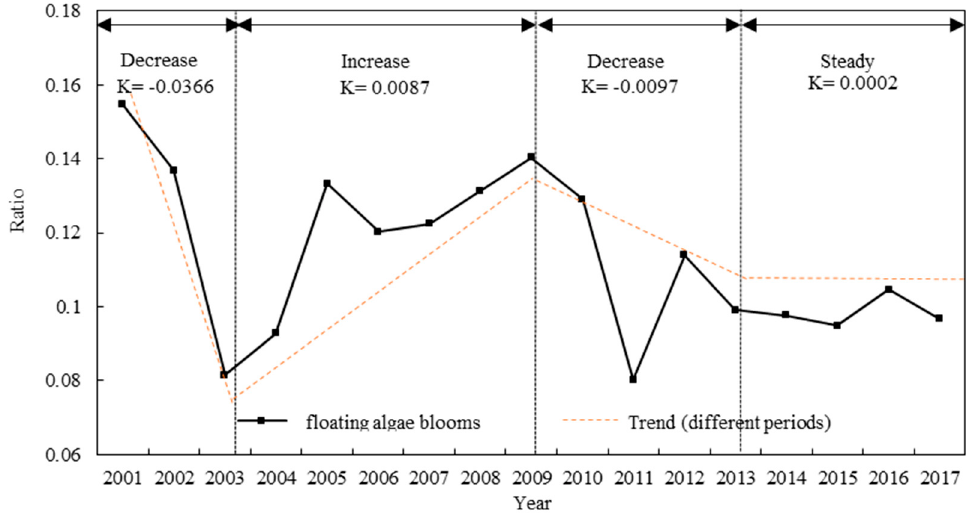
Figure 11. Percentage of the algal bloom area relative to the entire lake area from 2001–2017. (K is the annual change in Y, and Y is the ratio of the bloom area to the area of Dongting Lake).